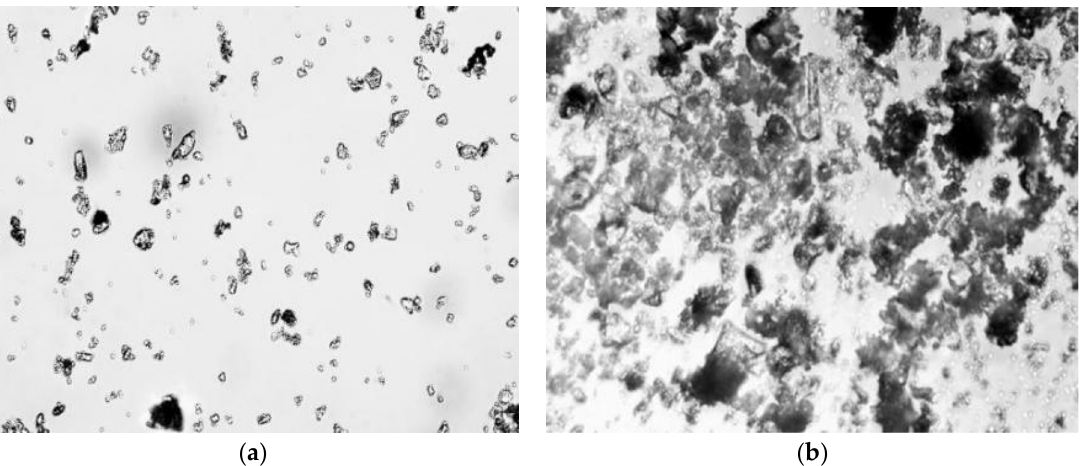
Figure 7. Effect of nano-metakaolin on flocculation structures of cement paste [11]. ( a ) Ordinary cement paste; ( b ) with 5% nano-metakaolin.